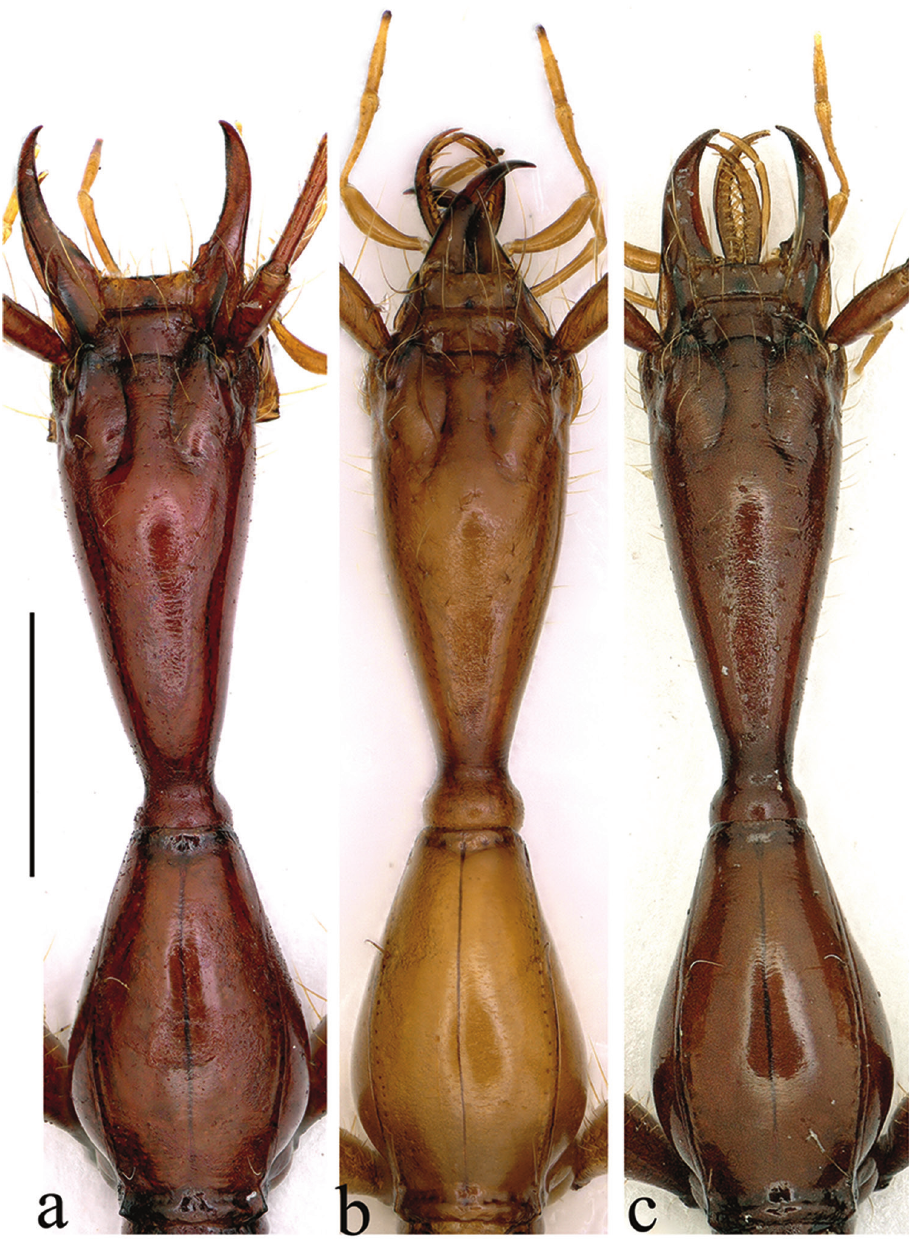
Figure 5. Head and pronotum of Dongodytes (s. str.) species a D. tonywhitteni sp. n. b D. fowleri c D. grandis . Scale bar: 1